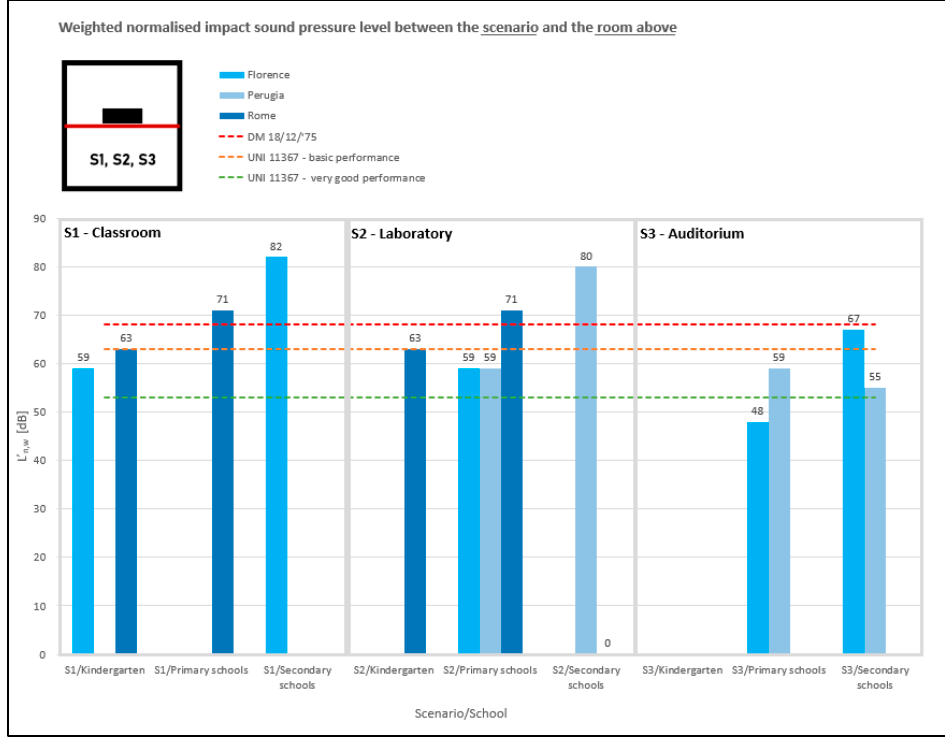
Figure 7. Weighted normalised impact sound pressure level (L’ n,w ) of the partition between the scenario and the room above carried out for scenarios S1, S2 and S3. L’ n,w has been analysed to determine the noise due to impact sound.